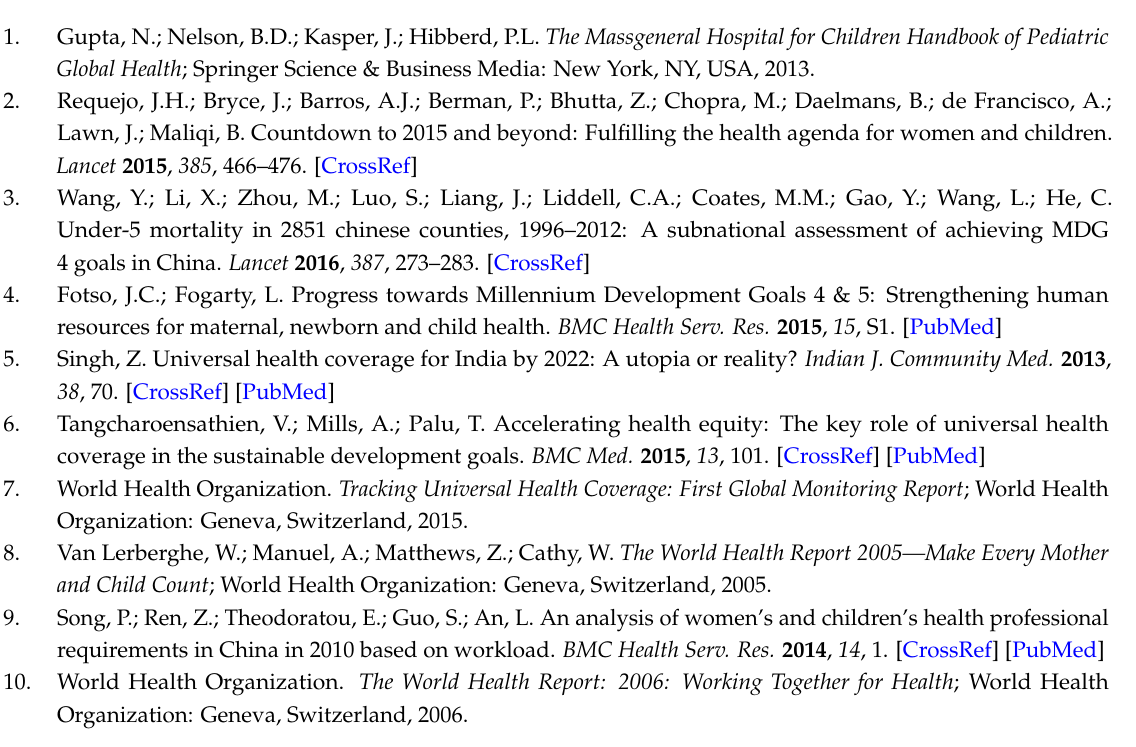
Table S1: The demographic distribution of paediatric workforce in the sampled districts/cities; Table S2: The geographic distribution of paediatric workforce in the sampled